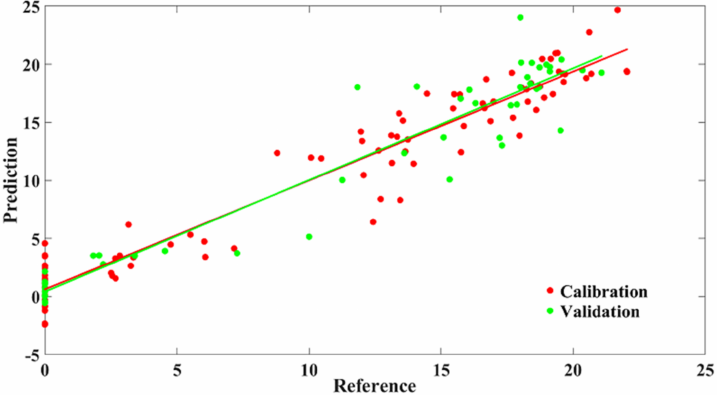
Figure 4. Prediction results of multi-band